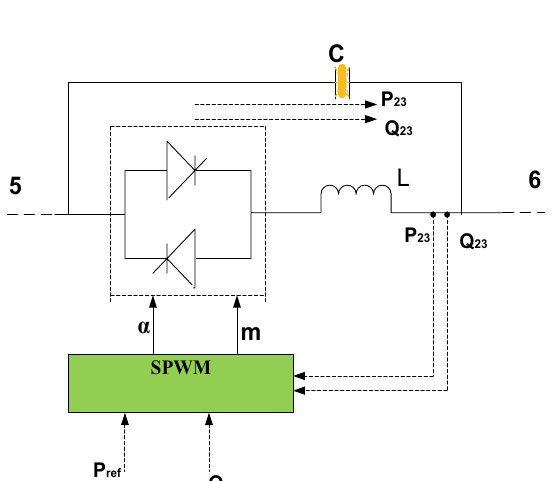
Fig. 7 Switching structure of thyristor in TCSC for IEEE 9 bus